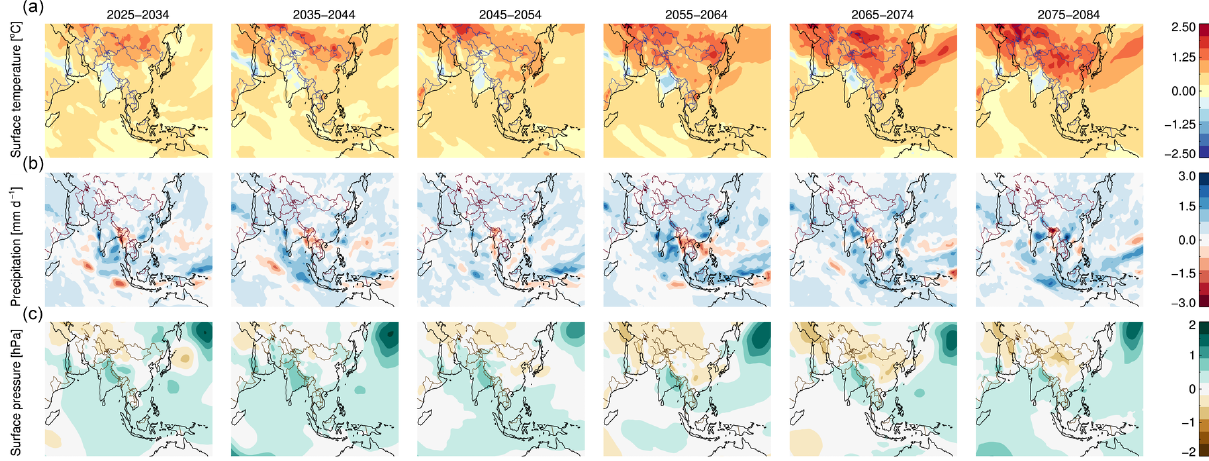
Figure 13. JJA-mean (a) near-surface temperature (K), (b) precipitation (mmd − 1 ), and (c) sea level pressure (hPa) anomalies for 10-year periods vs. 1980–2014 from an anthropogenic aerosol only version of SSP2-4.5 (SSP2-4.5-aer) with MIROC6.